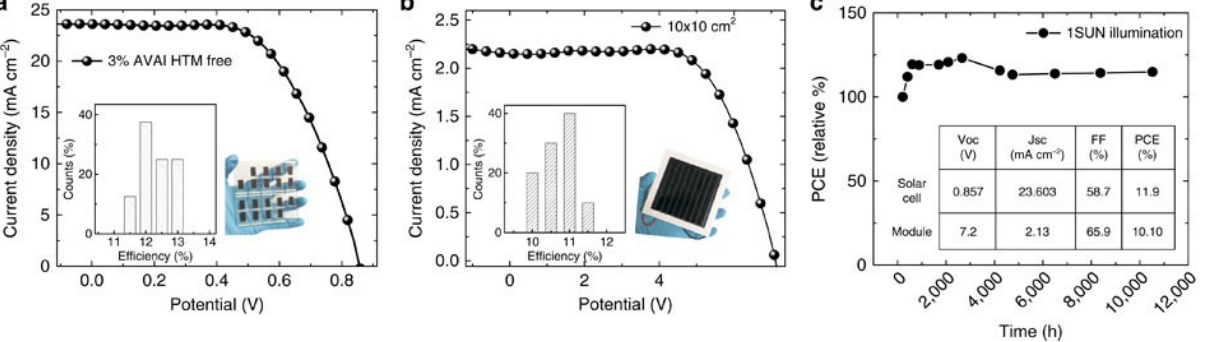
Figure 16. Characteristics and stability of 2D/3D carbon-based solar cells. ( a ) J–V curve using the 2D/3D perovskite with 3%AVAI in HTM-free solar cells measured under air mass (AM) 1.5 G illumination (device statistics and picture in the inset). ( b ) J–V curve using the 2D/3D perovskite with 3%AVAI in an HTM-free 10 × 10 cm 2 module (device statistics and picture in the inset). ( c ) Typical module stability test under 1 sun AM 1.5 G conditions at stabilized temperature of 55 °C and in short-circuit conditions. Stability measurements conducted according to the standard aging conditions. In the inset are device parameters of the devices represented in ( a , b ) [94]. (Reproduced from Ref. [94], 10.1038/ncomms15684, under the terms of the CC BY [4.0] license).